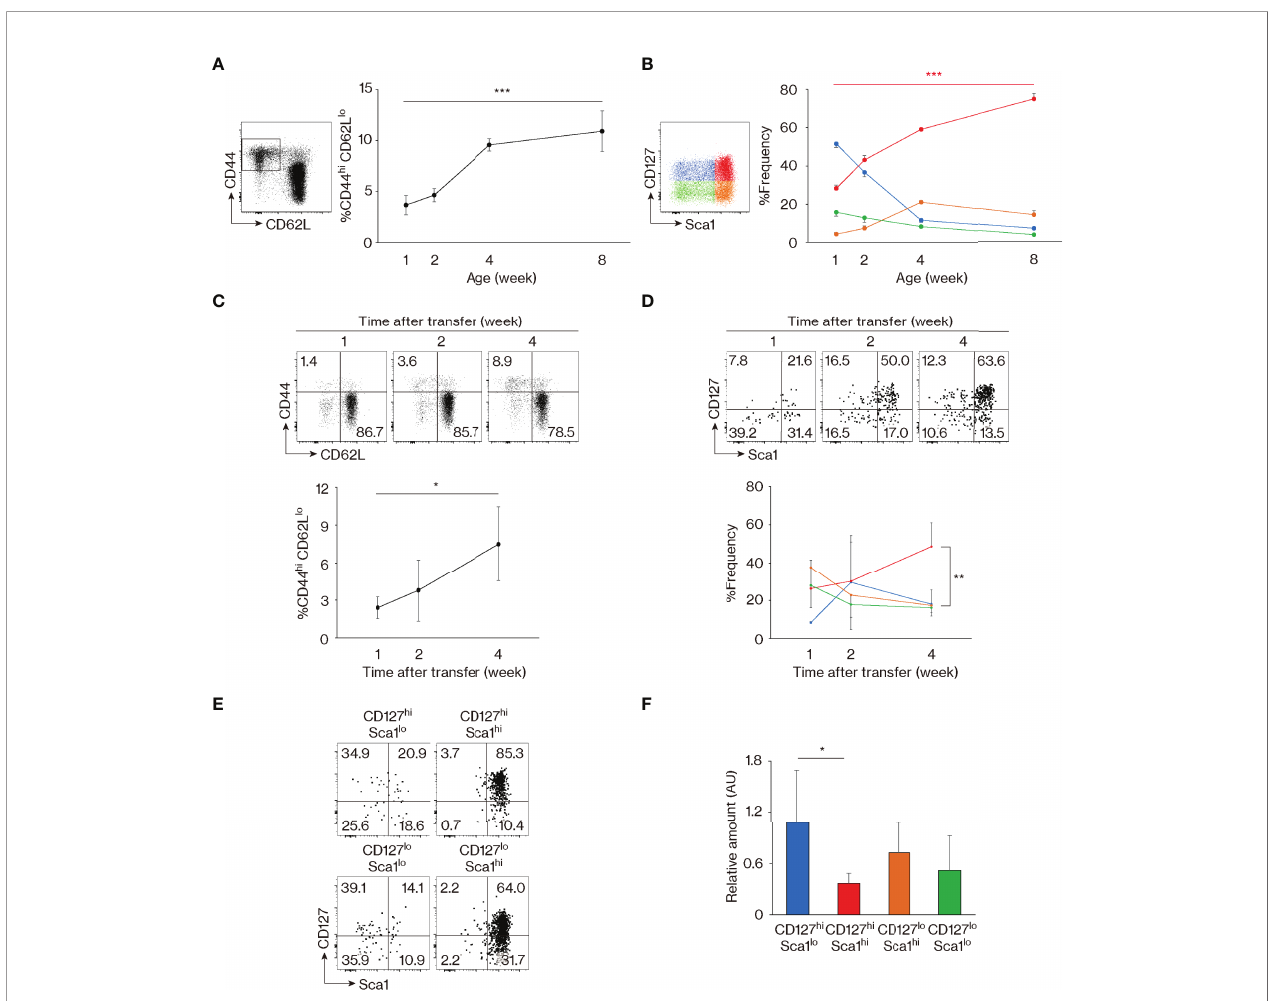
FIGURE 3 | Memory-phenotype (MP) T lymphocytes are composed of four subsets representing different stages of maturation. (A, B) CD127 hi Sca1 hi MP cells develop with age. The graphs indicate the fractions (mean ± SD) of (A) CD44 hi CD62L lo among CD4 + T cells and (B) each subpopulation among MP cells (n = 3 – 5 mice). Representative dot plots displaying expression of (A) CD44 and CD62L in CD4 + T lymphocytes and (B) CD127 and Sca1 in MP CD4 + T cells are also included. Data shown are pooled from 2 independent experiments performed. (C, D) CD127 hi Sca1 hi MP cells are generated from naïve precursors. Naïve CD4 + T lymphocytes sorted from CD45.2 mice were transferred to CD45.1 wild-type (WT) recipients and analyzed several weeks later. Dot plots show (C) CD44 and CD62L expression in the donor cell population and (D) CD127 and Sca1 levels in the newly generated MP donor cells, while the graphs indicate the frequency (mean ± SD) of (C) MP cells in the donor cell population and (D) the indicated subpopulations among MP donor cells (n = 3 – 4 mice). Data are representative of 2 independent experiments. (E) All four MP subsets eventually differentiate into CD127 hi Sca1 hi cells. Four MP subpopulations sorted from CD45.2 mice were transferred to CD45.1 WT recipients and analyzed for their CD127 and Sca1 expression 2 weeks later. Dot plots in the indicated donor MP subpopulations are shown. Data are representative of 4 – 5 recipient mice from 3 independent experiments performed. (F) CD127 hi Sca1 hi MP T lymphocytes have the lowest amount of TRECs. A bar graph indicating the amount (mean ± SD) of TRECs relative to Gapdh that was calculated by the D Ct method in each MP subpopulation is depicted (n = 5 mice). Data are representative of 2 independent experiments performed. Statistically signi fi cant differences are indicated as * p < 0.05, ** p < 0.01, and *** p <